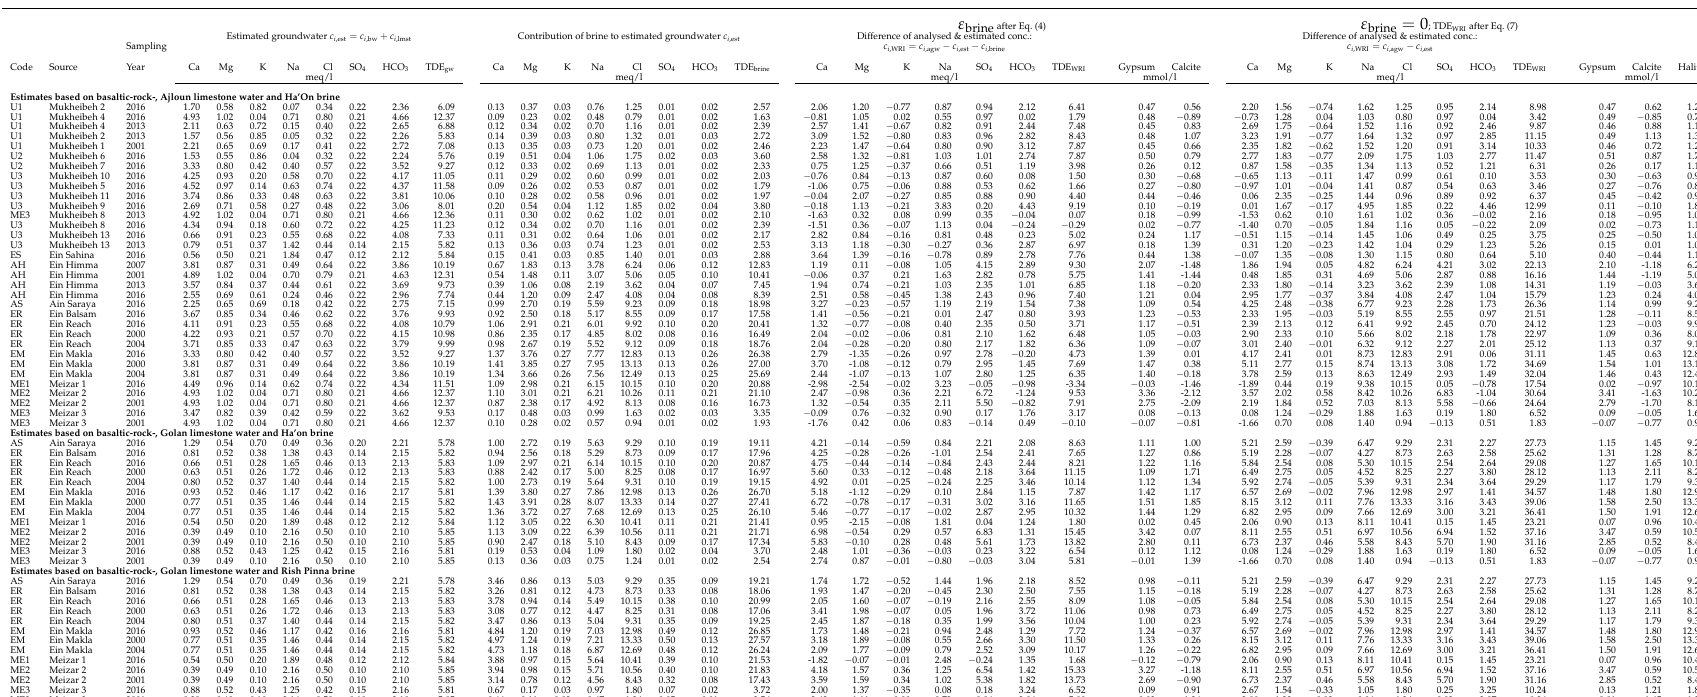
Table A2. Estimation of brine and water/rock contributions to the salinity of groundwaters. (a) The contribution of the basaltic-rock water, the sum of basaltic rock and limestone water; the contributions of brine are estimated based on brine after Equation (2). The difference between analyzed and estimated concentrations yield the contribution of water/rock interaction here presented as gypsum and calcite dissolution. (b) Similar to (a) but brine is set to zero. Consequently, only the sum of water/rock interaction and brine is